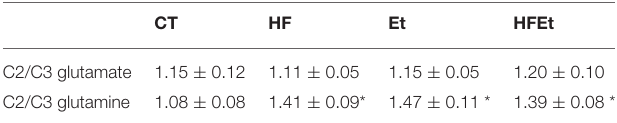
Frontiers in Nutrition |